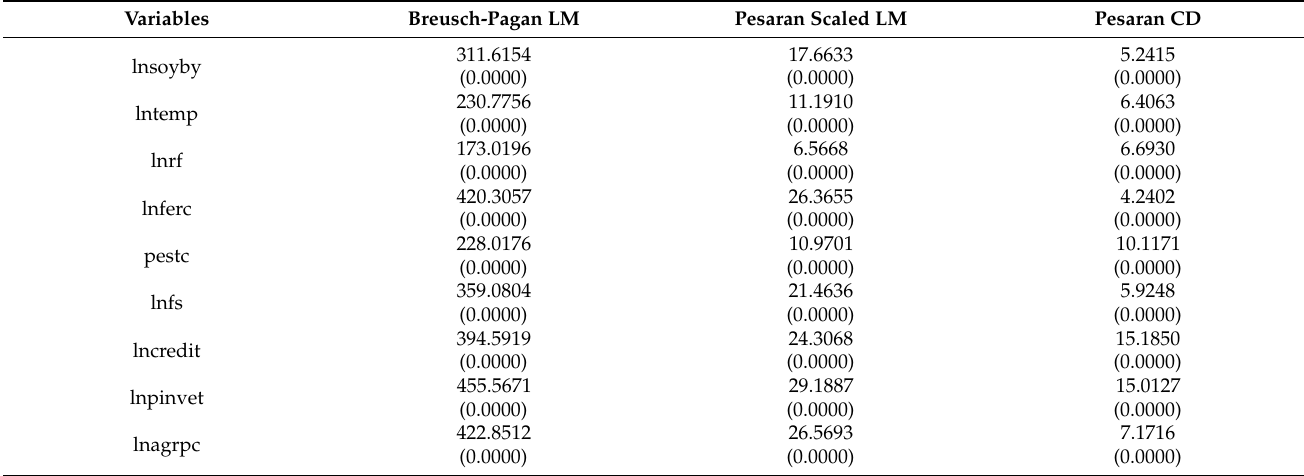
Table 3. Cross-sectional dependence testing results.